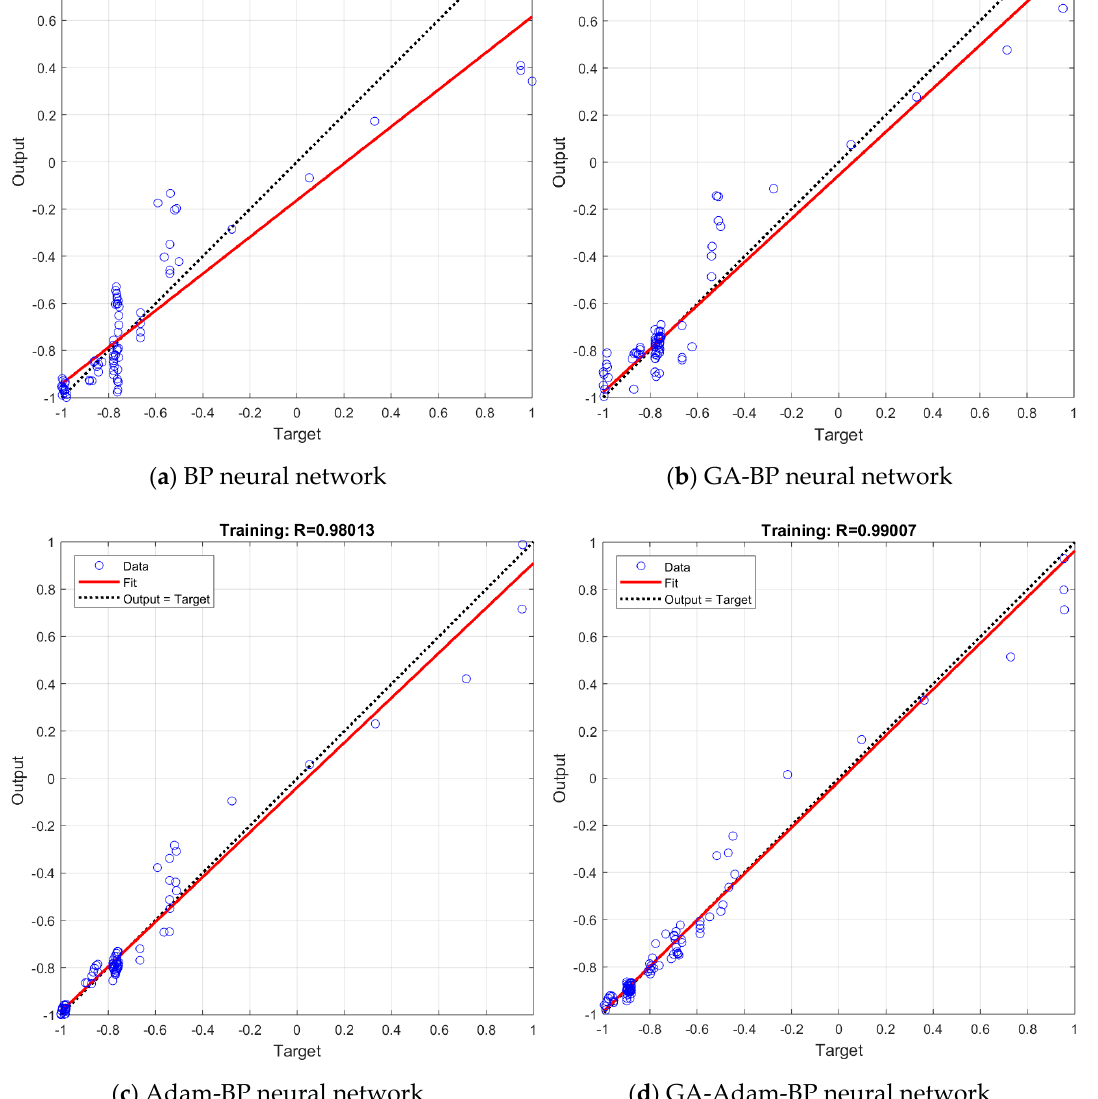
Figure 15. The regression analysis of test data of four neural network models.